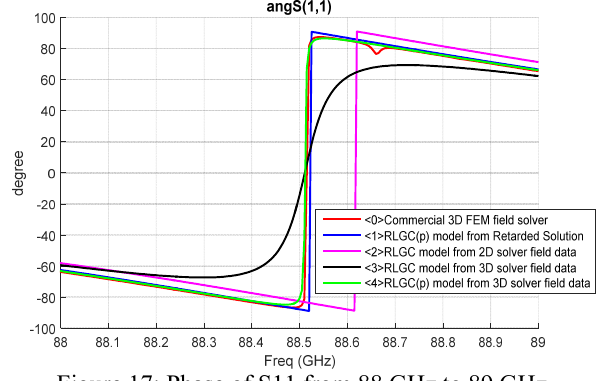
Figure 17: Phase of S11 from 88 GHz to 89 GHz